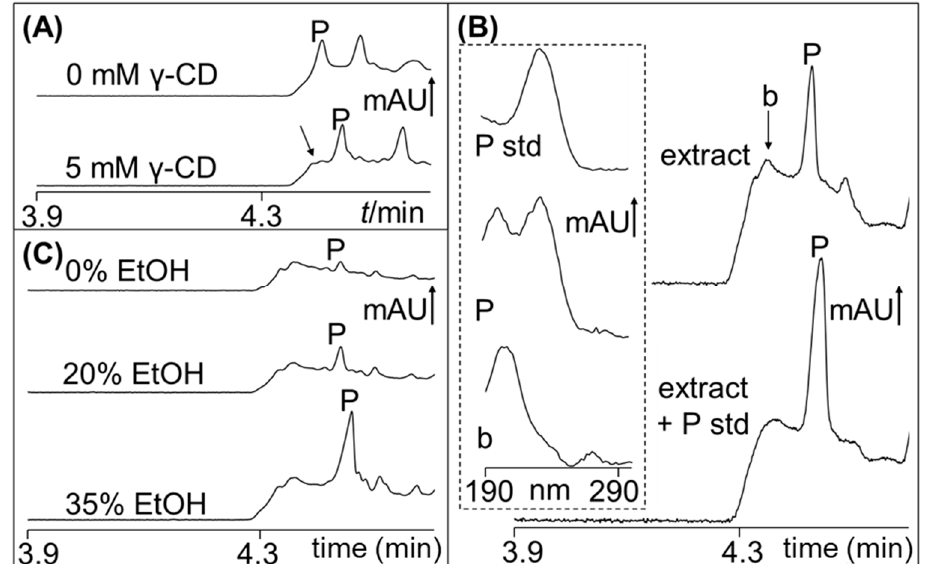
Figure 1. Representative micellar electrokinetic chromatography (MEKC) electrochromatograms of Tasmannia lanceolata leaf extracts. P is the peak of polygodial. ( A ) Effect of γ -cyclodextrin ( γ -CD)